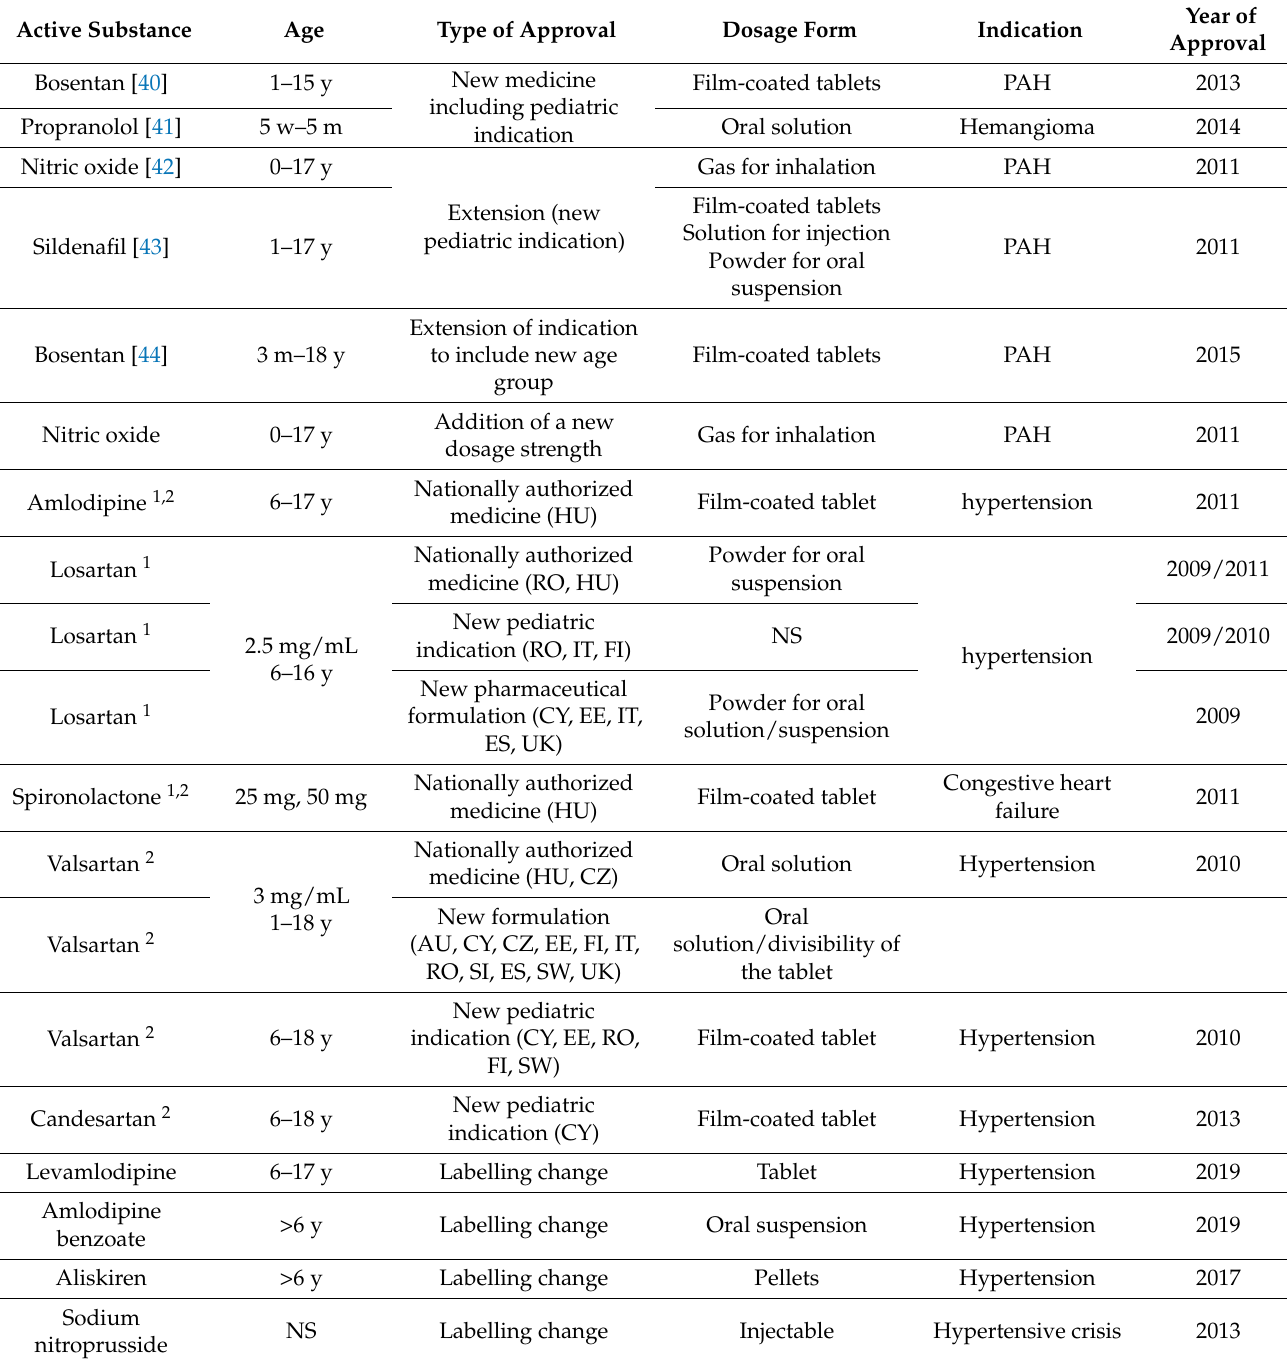
Table 1. Approved medicines for pediatric